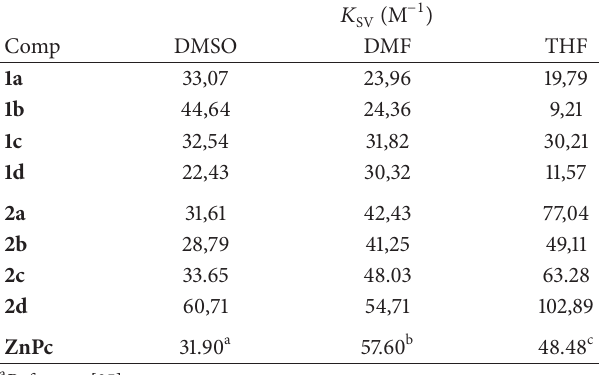
Table 3: Fluorescence quenching data of substituted zinc phthalo- cyanine complexes ( 1a–1d and 2a–2d ) in DMSO, DMF, and THF.